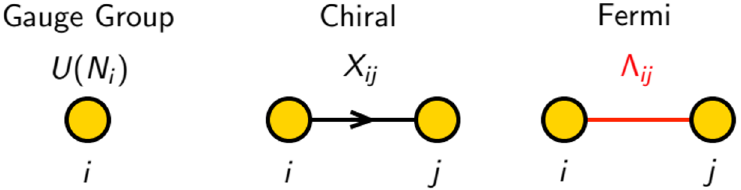
Figure 6 . Quiver representation of U( N i ) gauge groups, chiral and Fermi fields. The subindices of field variables indicate the gauge nodes under which they transform. Fermi fields are not assigned an orientation due to the Λ Λ symmetry. ij ↔ ji